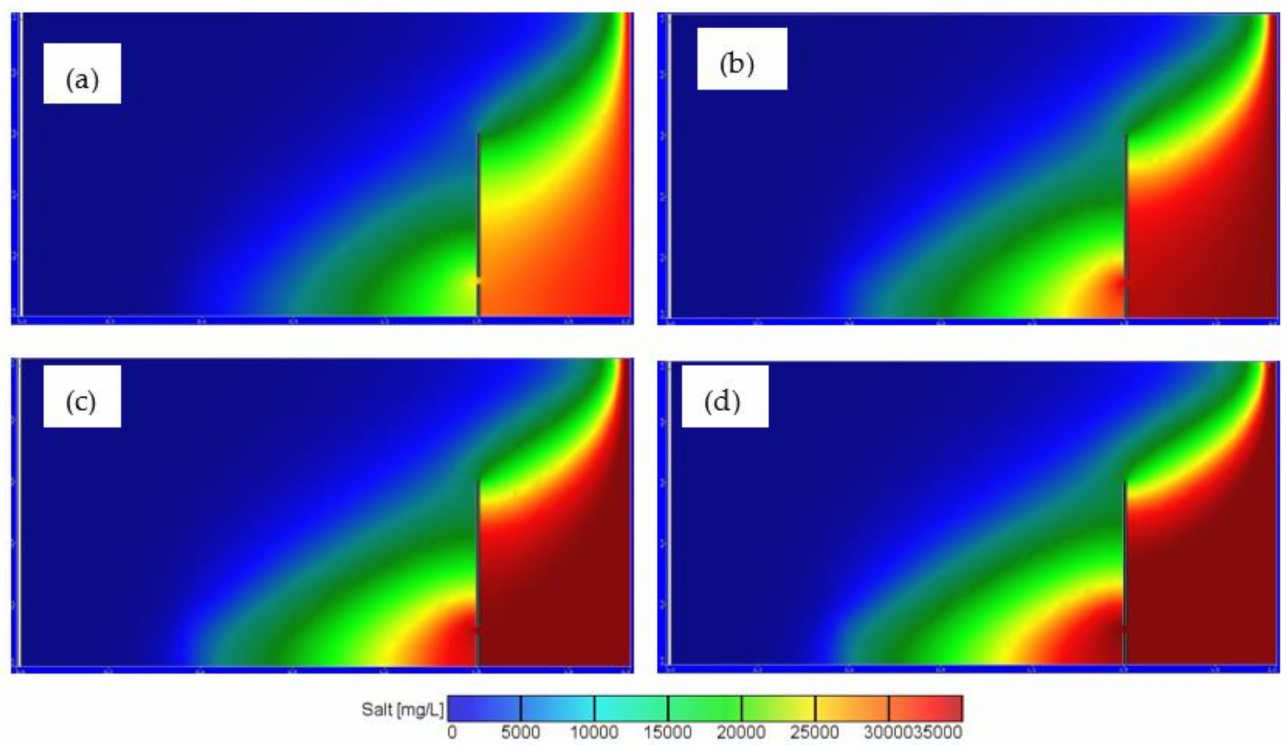
Figure A3. Salinity distribution for D f = 0.01 m, H f = 0.1 m, L d = 0.5 m for different values of saltwater density: ( a ) 1025 kg/m 3 ( b ) 1025 kg/m 3 , ( c ) 1027 kg/m 3 , ( d ) 1030 kg/m 3